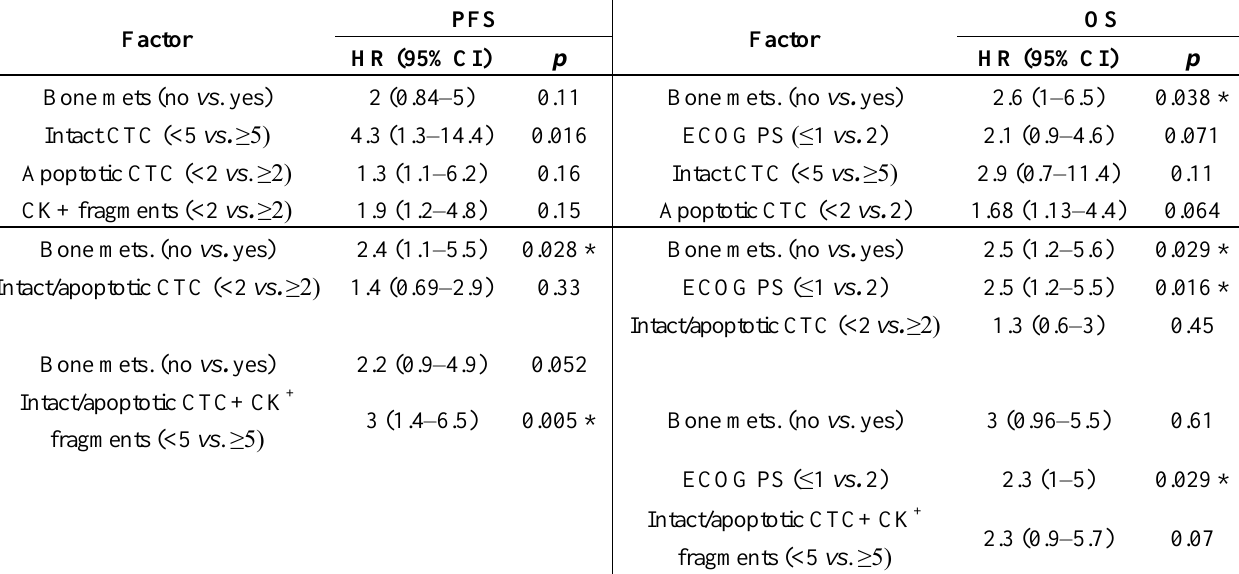
Table 4. Multivariate Cox regression